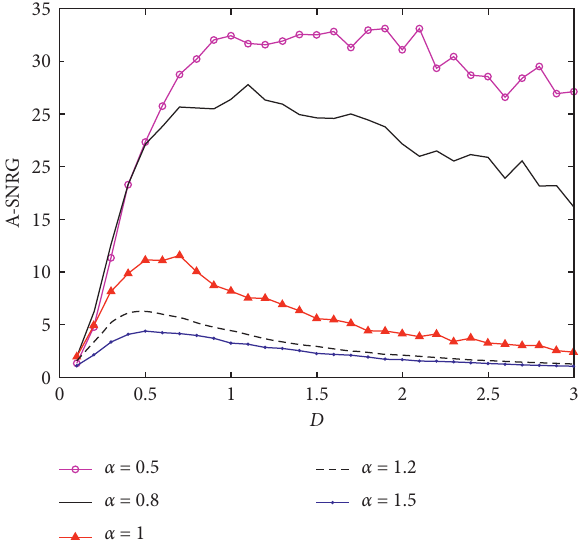
α = 0.6 Figure 8: A-SNRG of SR with asymmetric depth of potential well as a function of potential function parameter q .